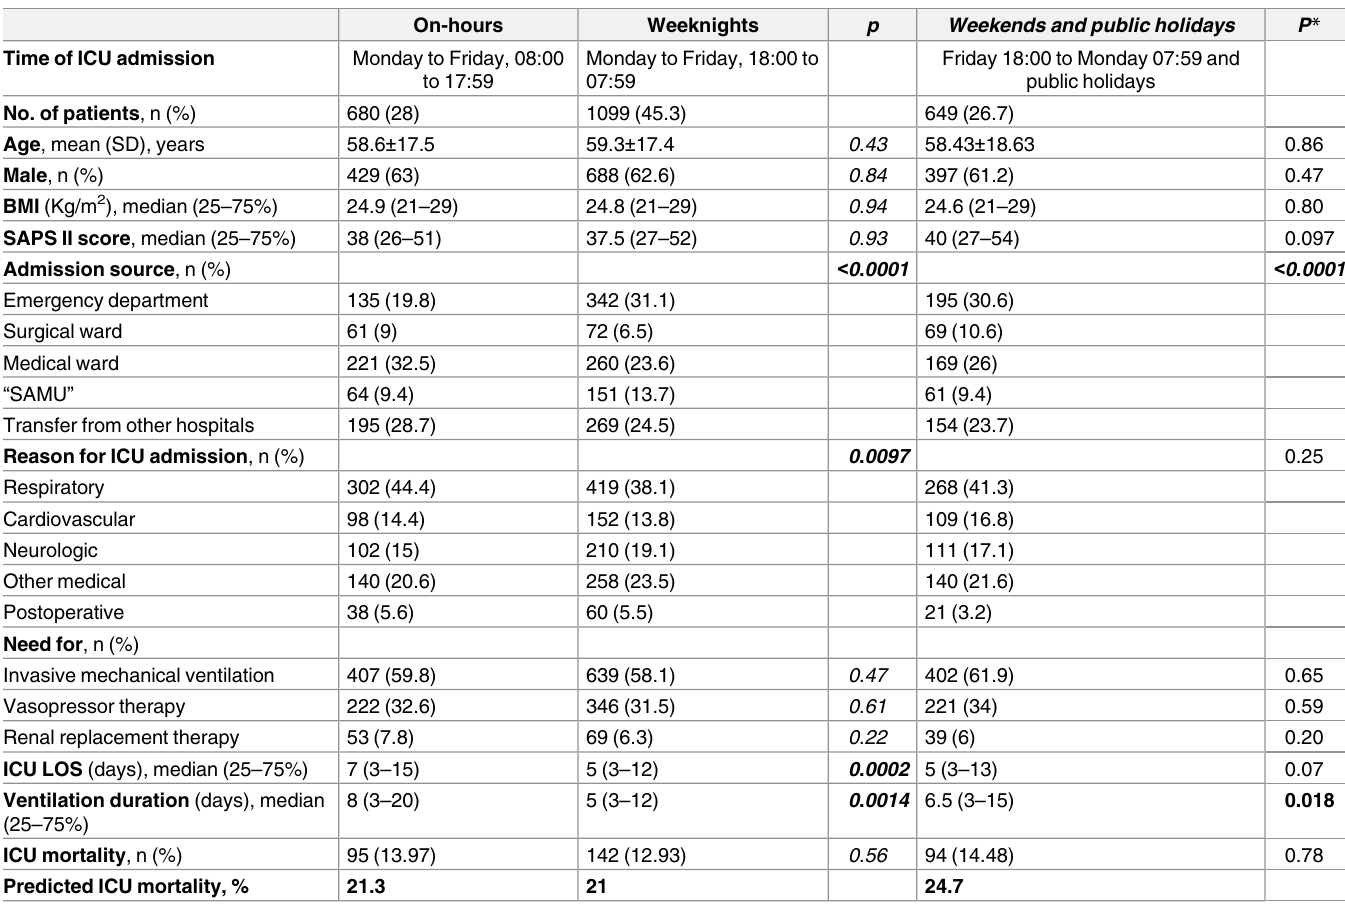
Table 3. Comparison of patients admitted during on-hours to those admitted during weeknights, and to those admitted during weekends and pub- lic holidays. Weekend admission was definedas admission between 08:00 am Sundayand 7:59 am Monday; BMI: body mass index; SAPS II: simplified acute physiologyscore II; ICU: intensivecare unit; LOS: length of stay; “SAMU”: Service d’AideMe´dicaleUrgente: mobile emergency team; p: On-hours vs Week-night; p * : On-hours vs weekendsand